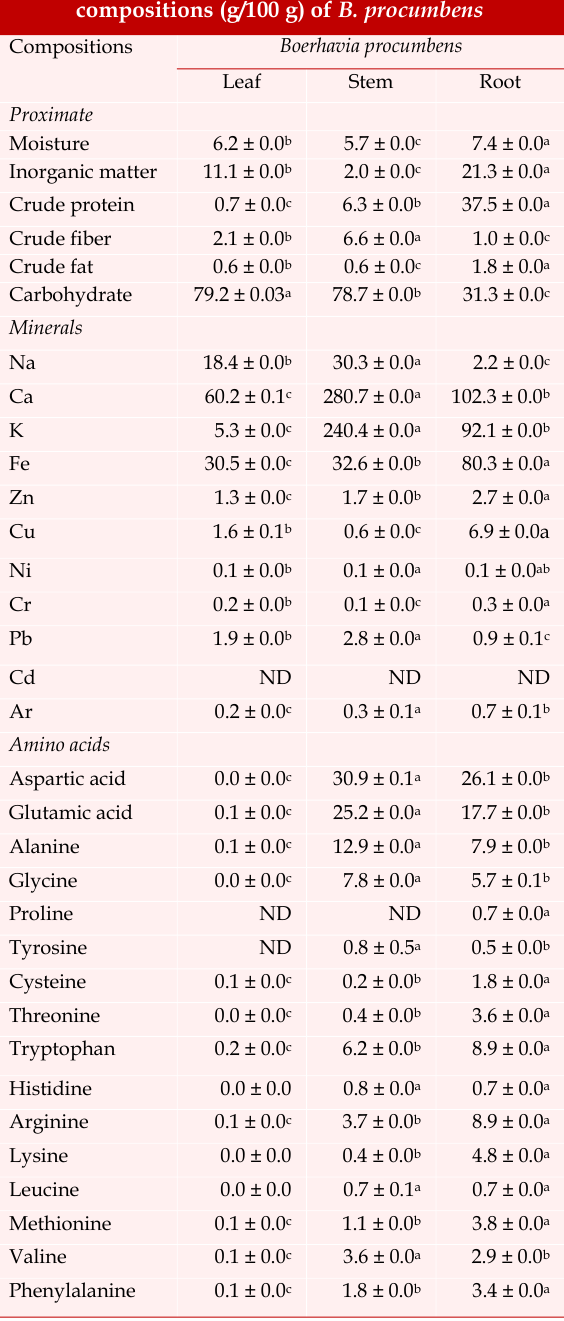
Proximate (%), minerals (mg/100 g) and amino acids compositions (g/100 g) of B.